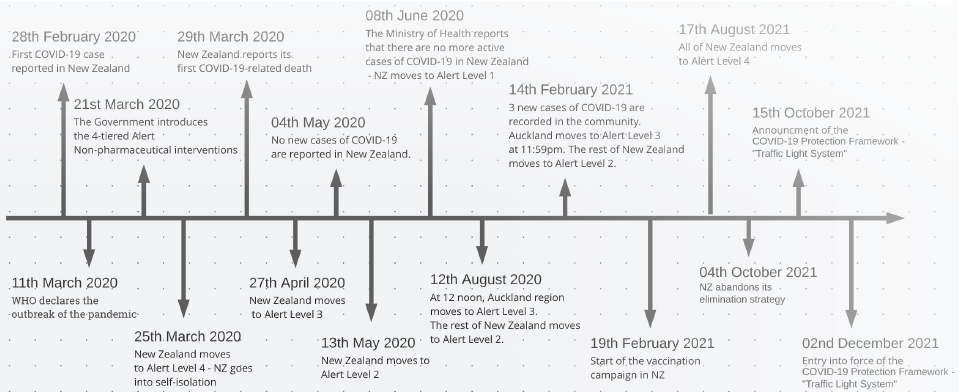
Figure 1. Timeline with dates of key events and policy decisions taken by the New Zealand gov- ernment. On March 25, New Zealand moved to Alert Level 4 due to a high incidence of daily SARS-CoV-2 cases. With the growing governmental stringency being implemented, the Alert Level returned to 1 within June 2021. Both in August 2021 and February 2021, Auckland moved to Alert Level 3, while the rest of the country reached Alert Level 2, with a higher stringency in accordance with Figure 2. In August 2021, the whole country moved to Alert Level 4, associated with a sharp rise of the incidence and stringency index.